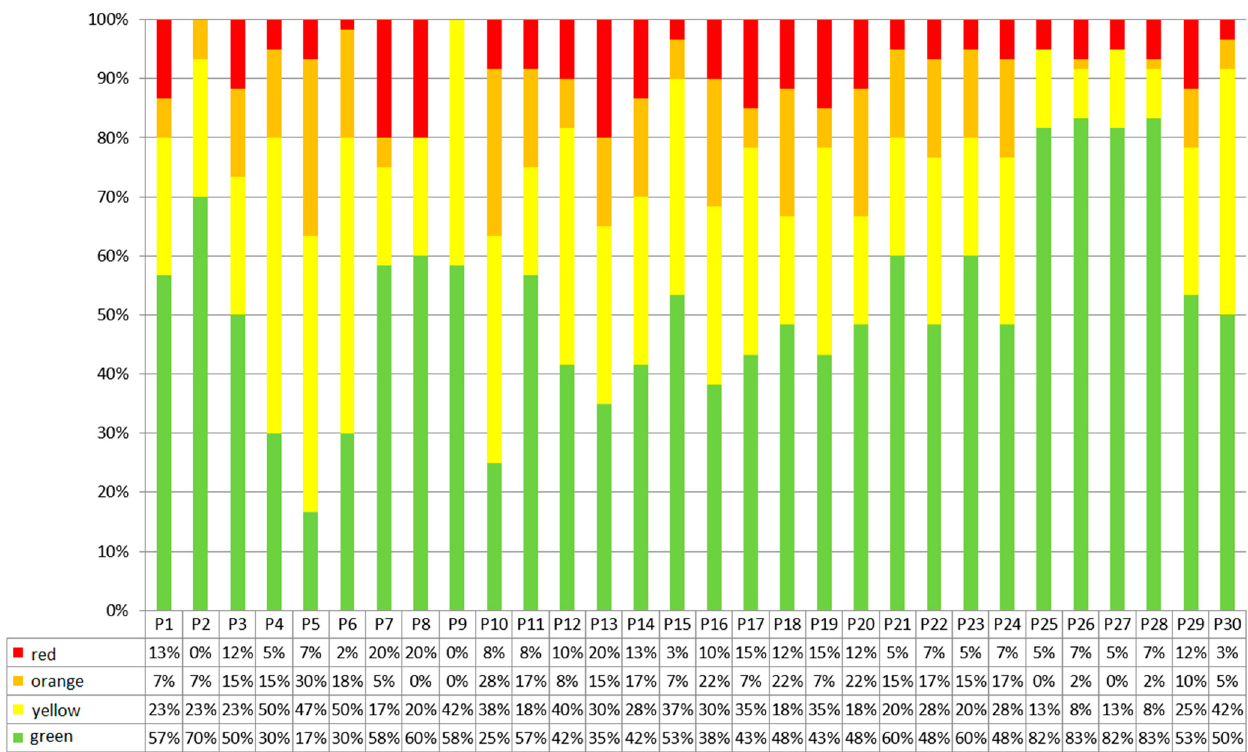
Figure 2. Percentage distribution of results in 4 defined ranges (green, yellow, orange and red) for 30 parameters obtained from patients after stroke—dominant upper limb.